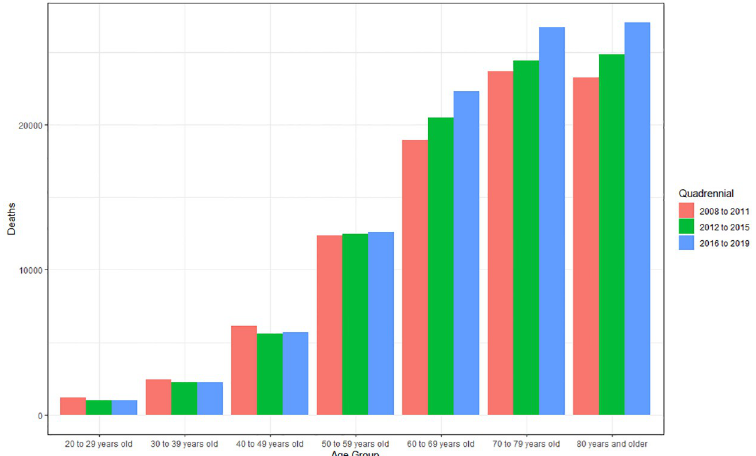
Fig 7. Average of deaths caused by cardiovascular diseases according to age group ( > 20 to 80 years and over) and quadrennium (2008 to 2011; 2012 to 2015; 2016 to 2019). Source: Ministry of Health–Hospital Information System of the Unified Health System (SIH/SUS)